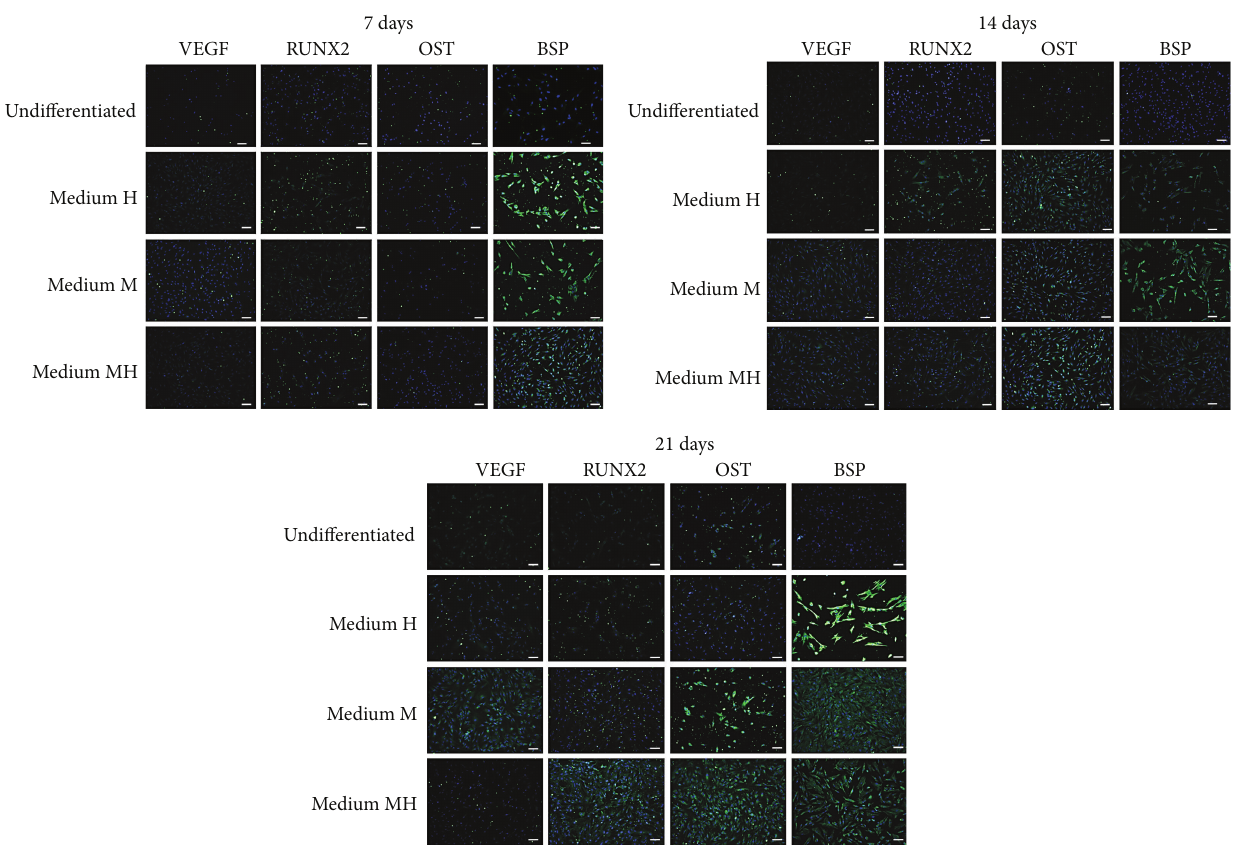
Figure 3: Analysis of osteogenic specific proteins. Expression of VEGF A, Runx2, osteocalcin (OCN), and bone sialoprotein (BSP) was assessed in cells cultured for 7, 14, or 21 days in the presence of one of the 3 conditioned media described under Materials and Methods and based on 0,01 M melatonin (medium M) or a mixture of HA 2 mg/mL + BU 5mM + RA 1 𝜇 M (medium H) or on a combination of melatonin together with HA + BU + RA (medium MH) or kept under an undifferentiated state by growing on medium C. Nuclei are labeled with 4,6-diamidino-2-phenylindole (DAPI, blue). Scale bars: 40 𝜇 m. The figures are representative of five separate experiments. For each differentiation marker, fields with the highest yield of positively stained cells are